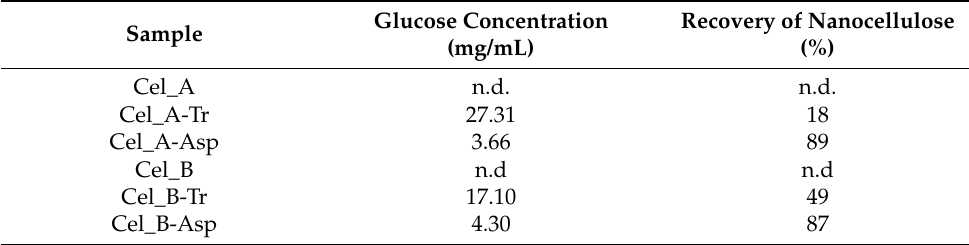
Table 2. Glucose concentration (in mg/mL) in post-reaction solutions (n.d.—not determined).